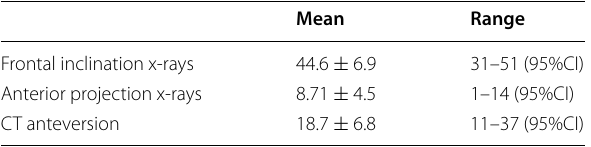
Table 3 Radiographic findings of cup placement on plain